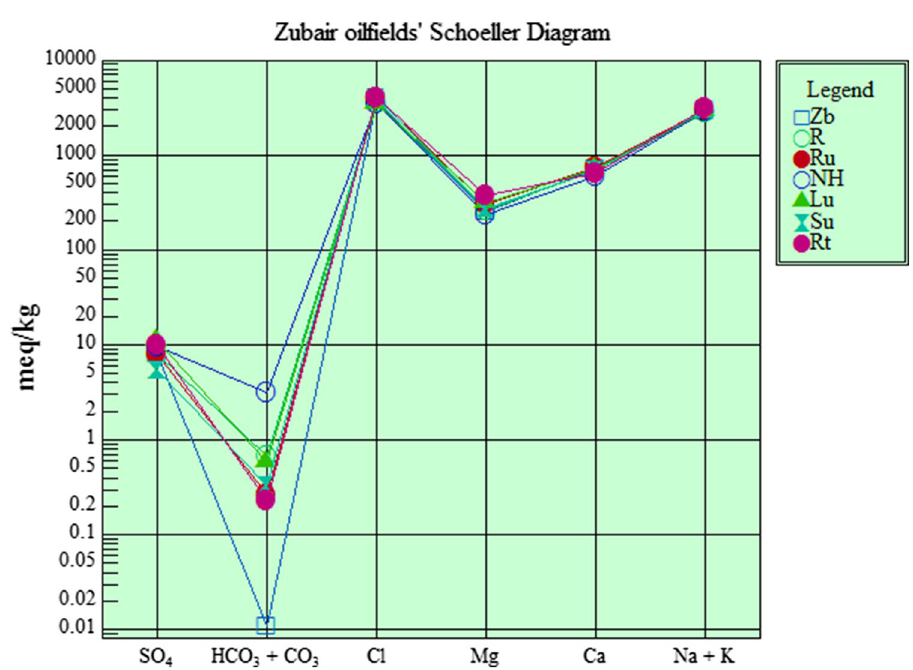
Fig. 4 Schoeller